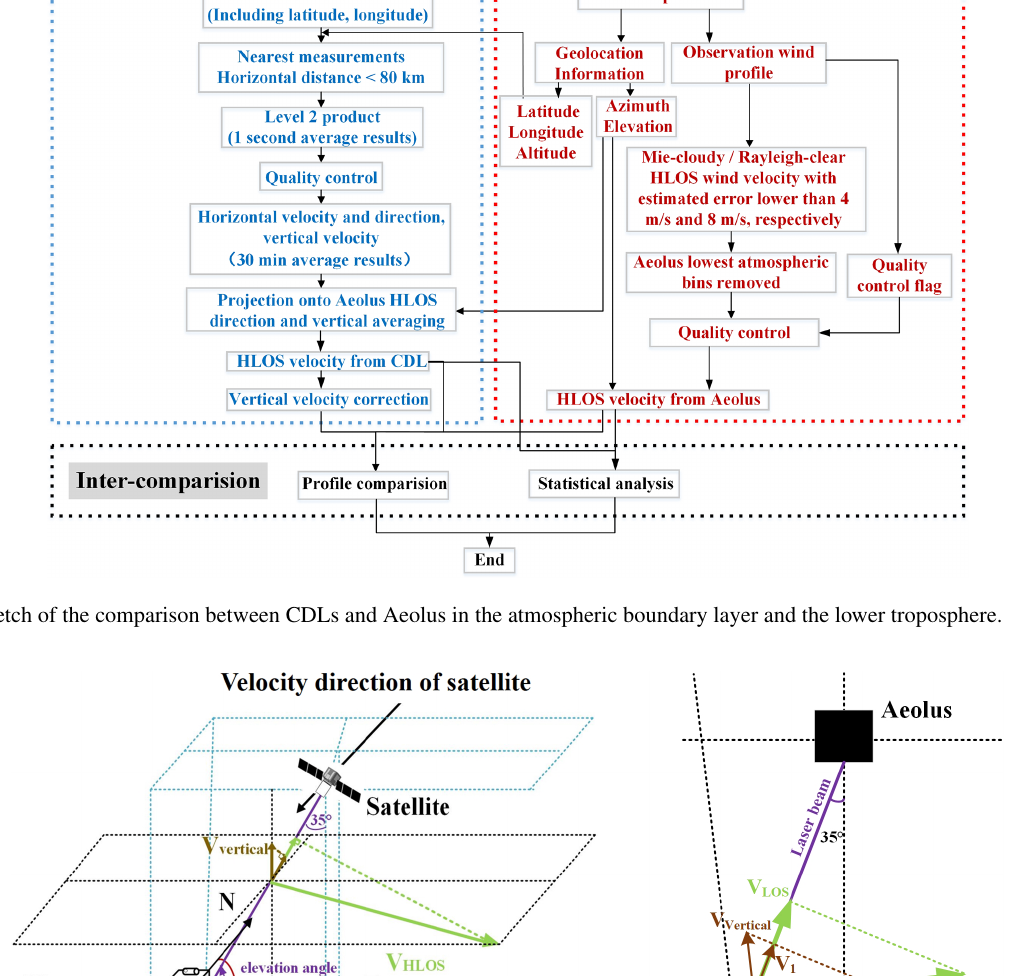
ucts. The vertical velocity profiles are shown as well.